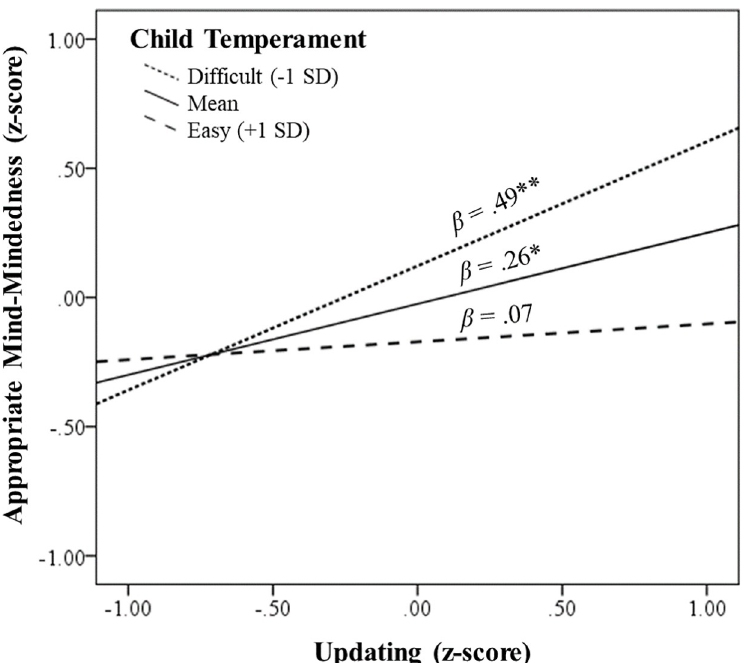
Fig 2. The links between updating (independent variable) and appropriate mind-mindedness (dependent variable) at levels of child temperament. Note . � p < .05, �� p <